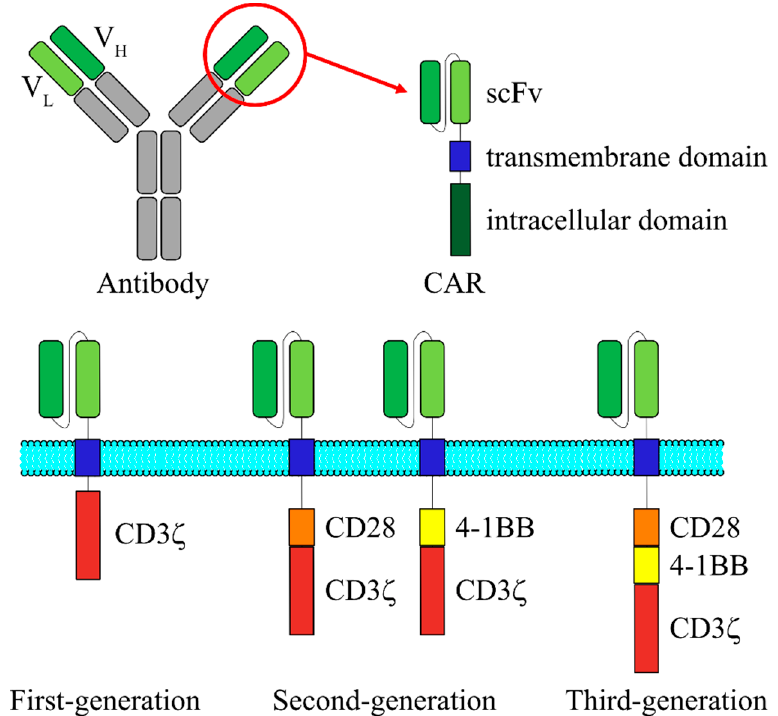
Figure 1. Schematic structure of the three generations of CARs. CAR is a fusion protein composed of an extracellular scFv that is derived from V H and V L regions of an antibody, a transmembrane domain and intracellular signaling domains derived from T cell signaling proteins. First-generation CAR contains only CD3 ζ chain for signal transduction. In addition to the CD3 ζ chain, second-generation CAR possesses one of the costimulatory receptor-derived signal transduction domains, such as from CD28 and 4-1BB. Third-generation CAR consists of two costimulatory domains. CAR, chimeric antigen receptor; scFv, single chain variable fragment; V H , variable heavy chain; V L , variable light chain.